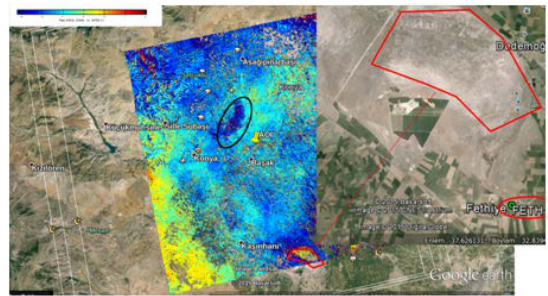
Figure 6. ALOS PALSAR DInSAR results from 608 track - 740 frame (2006/06/24-2006/09/24 ifg- 93 days), FETH is GPS point